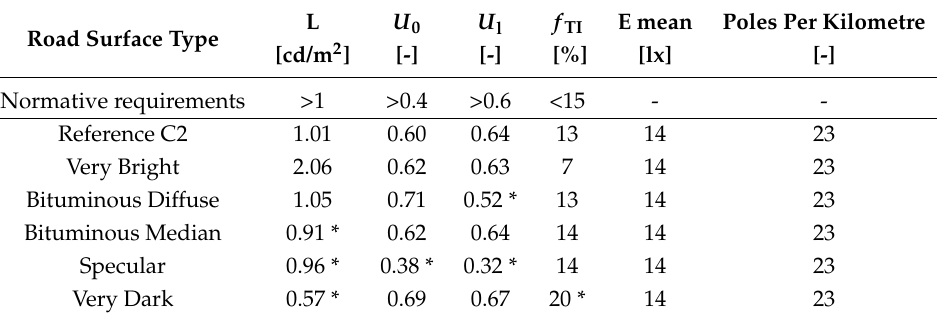
Table 7. Road lighting design values for Case